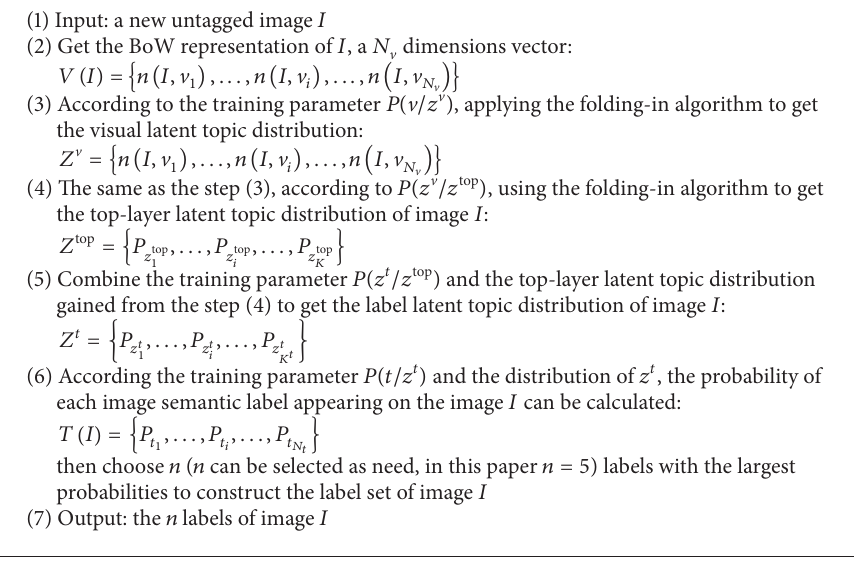
Algorithm 1: The image concept detection algorithm. Table 1: Results on Corel5K by our algorithm: AR (average recall) and AP (average